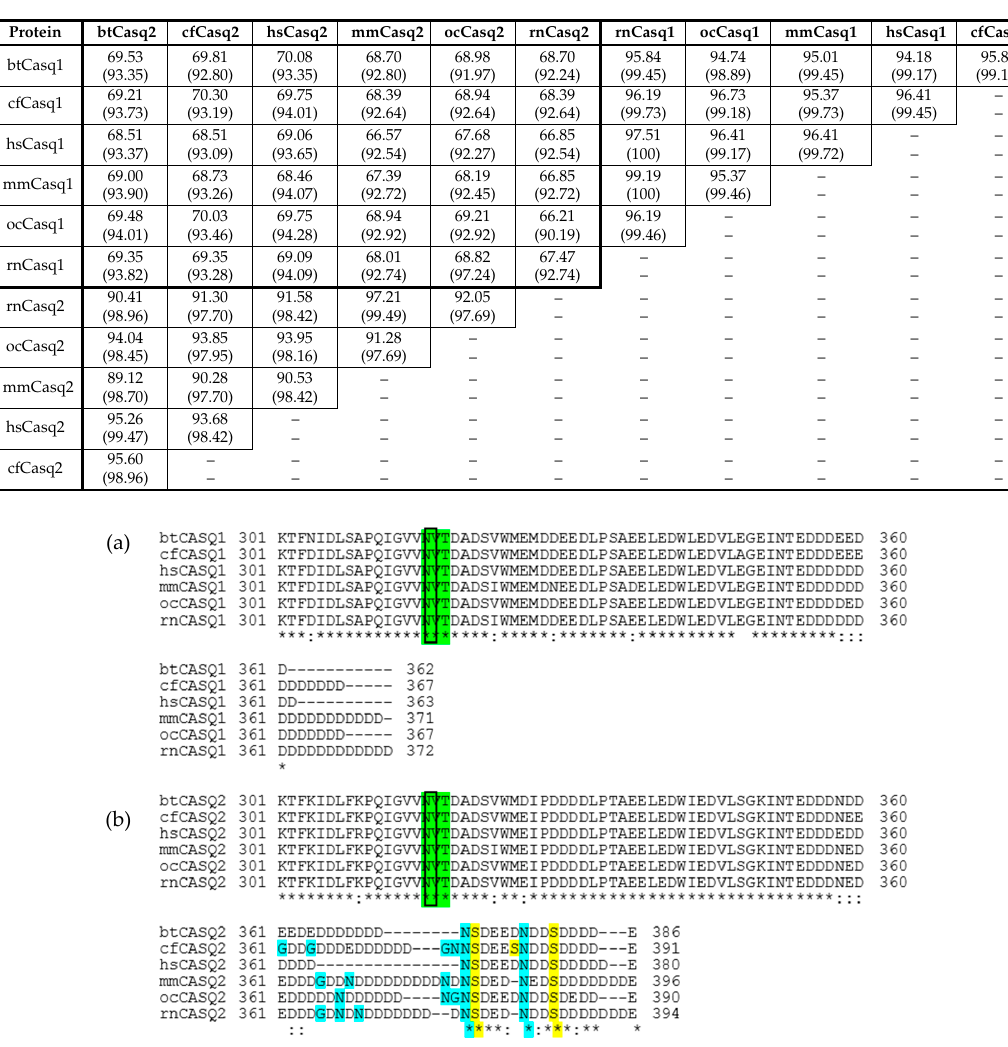
Figure 9. Casq1 and Casq2 sequence alignment of regions containing post-translational modifications (from Lys301 to the C-terminus). Asterisks indicate conserved residues, and colons indicate conserved substitutions. The eukaryotic N-linked glycosylation consensus sequence, conserved between Casq1 and Casq2, is highlighted in green, and the glycosylated residue, Asn316, is emphasized with a box. ( a ) Sequence alignment of bovine Casq1 (btCasq1), canine Casq1 (cfCasq1), human Casq1 (hsCasq1), mouse Casq1 (mmCasq1), rabbit Casq1 (ocCasq1) and rat Casq1 (rnCasq1); ( b ) sequence